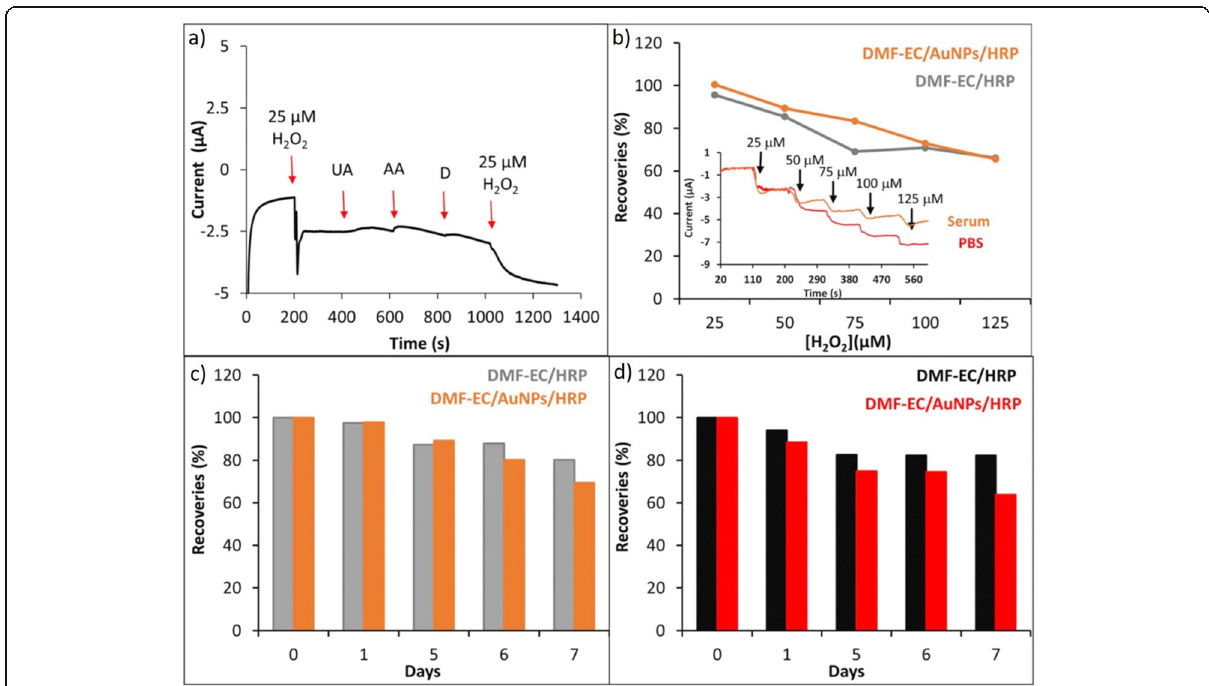
Fig. 13 a Selectivity assay of DMF-EC/AuNPs/HRP for H 2 O 2 analysis in the presence of 50 μ M of uric acid (UA), ascorbic acid (AA), and dopamine (D). b Accuracy assay of DMF-EC/AuNPs/HRP and DMF-EC/HRP) for H 2 O 2 detection. Long-term stability response of 3D DMF-EC/HRP and 3D DMF- EC/ AuNPs/HRP biosensors for 25 ( c ) and 50 ( d ) μ M H 2 O 2 detection. Reproduced with permission from